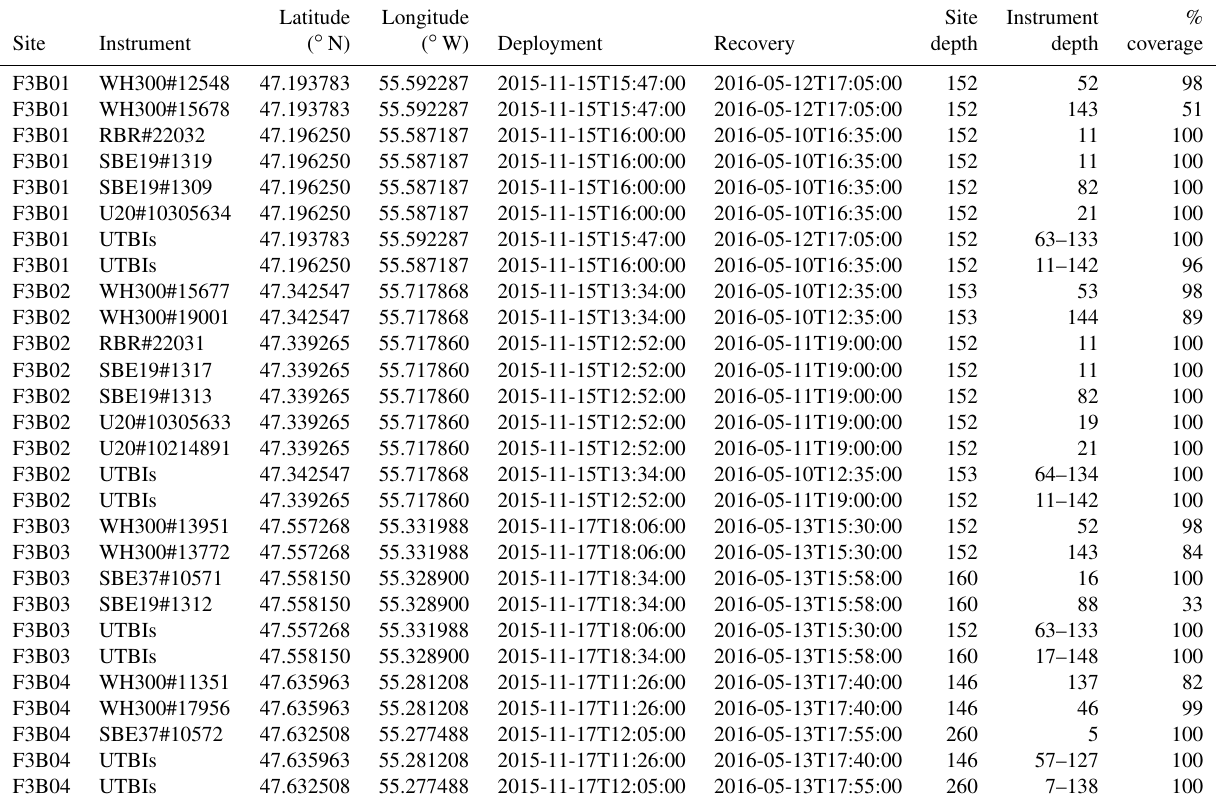
Table B2. Data collection summary, leg 2 (November 2015–May